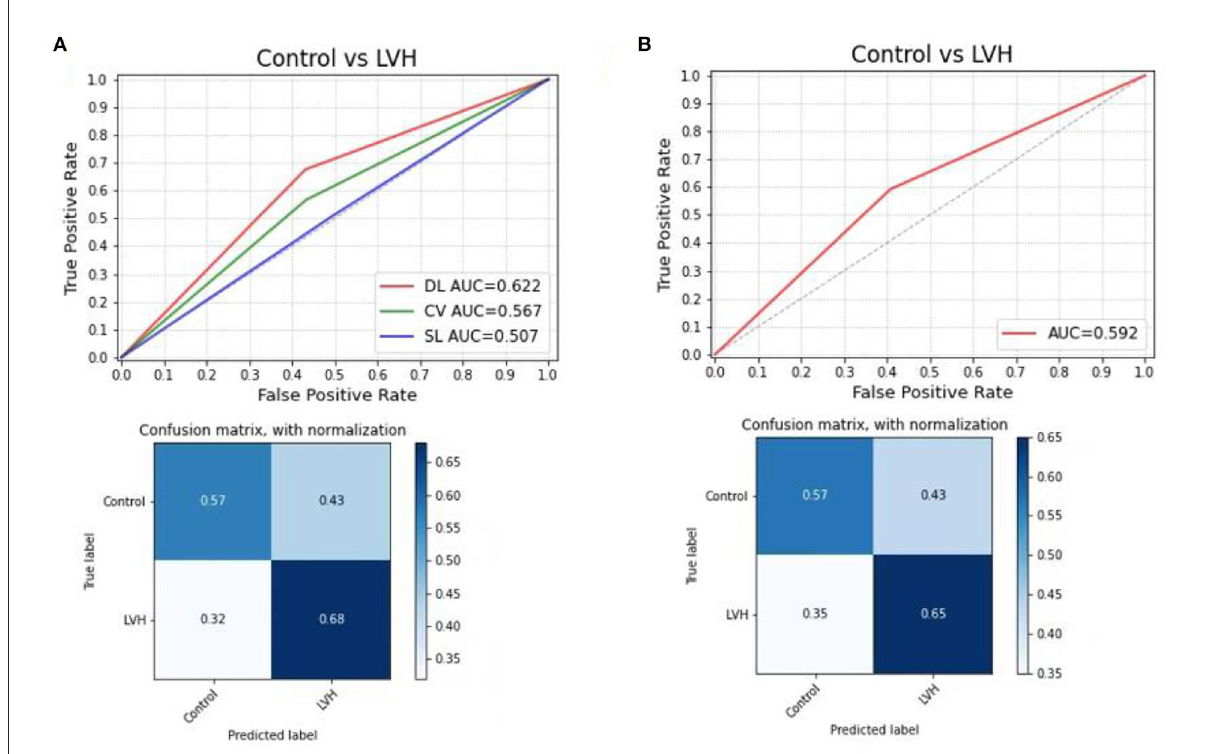
FIGURE2 Receiver operating characteristic curve analysis, (A) compared the DL model with Cornell voltage and Sokolow-Lyon voltage in test set 1, the confusion matrix for predicting control and LVH using the DL model in the test set 1; (B) to test the DL model in internal test set 2. DL, deep learning model; CV, Cornell voltage, SL, Sokolow-Lyon